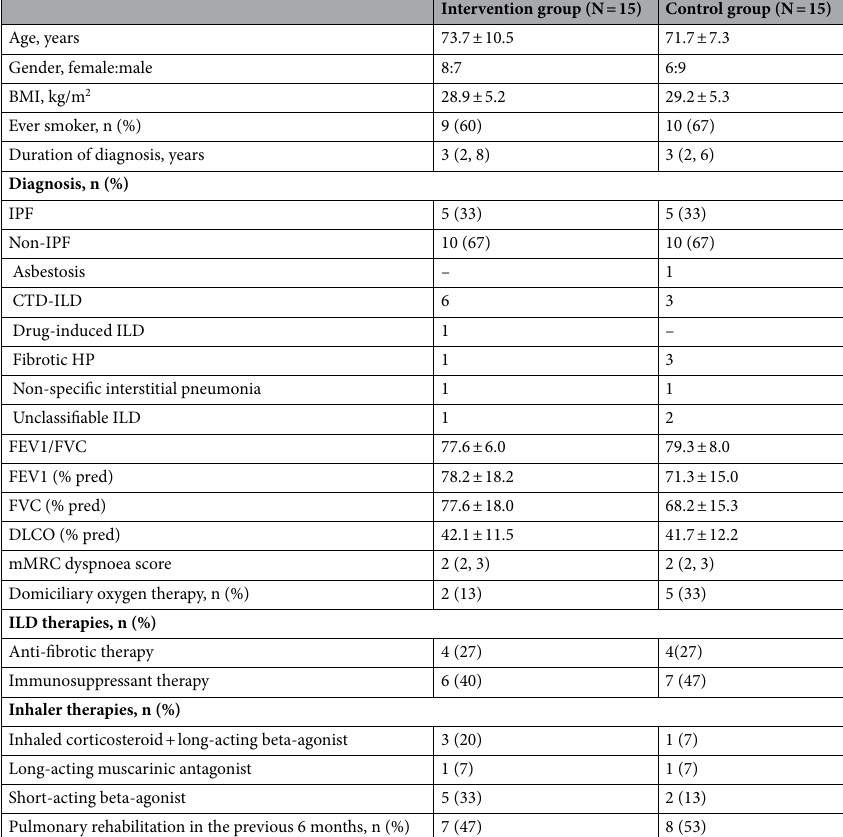
Table 1. Baseline participant characteristics. Data are expressed as mean ± standard deviation or median (interquartile range), except where indicated. BMI body mass index, CTD-ILD connective tissues disease- related interstitial lung disease, DLCO diffusing capacity for carbon monoxide, FEV1 forced expiratory volume in one second, FVC forced vital capacity, HP hypersensitivity pneumonitis, ILD interstitial lung disease, IPF idiopathic pulmonary fibrosis, mMRC modified Medical Research Council.